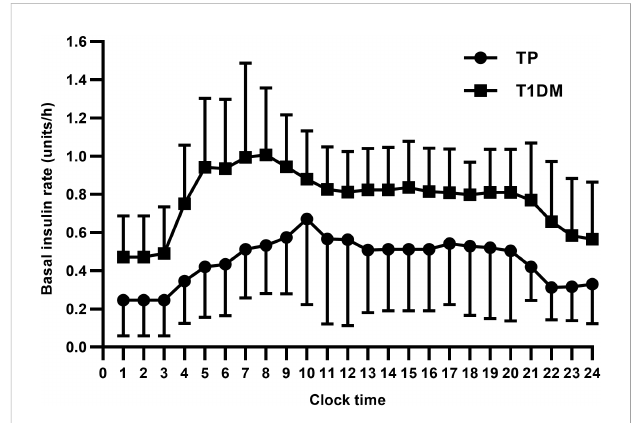
FIGURE 4 TP, total pancreatectomy; T1DM, type 1 diabetes mellitus. Data are presented as mean ± SD. All P values were less than